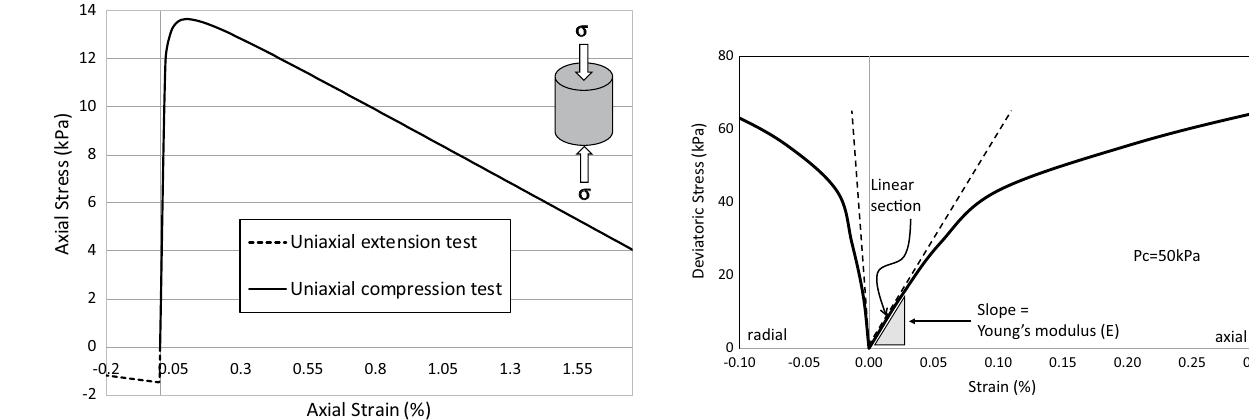
Fig. 4 Uniaxial compression and extension test response